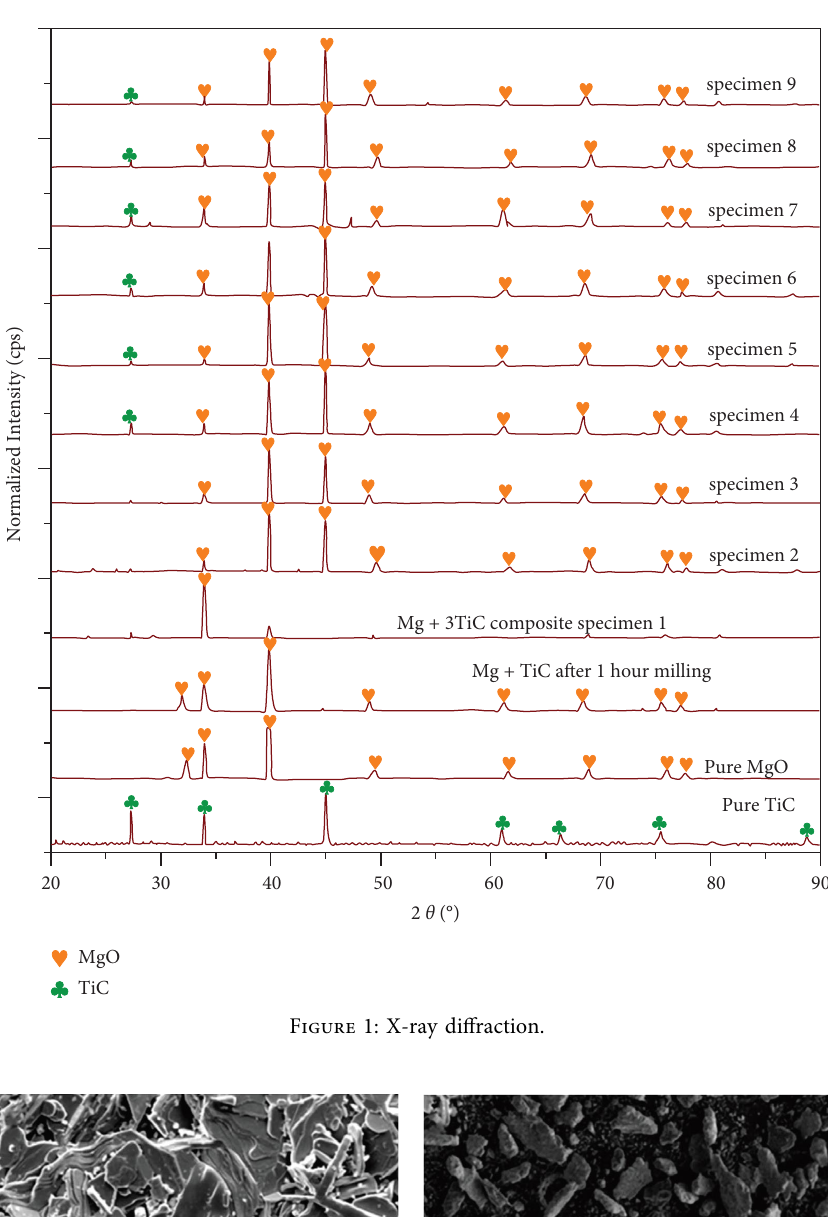
Figure 1: X-ray difraction.